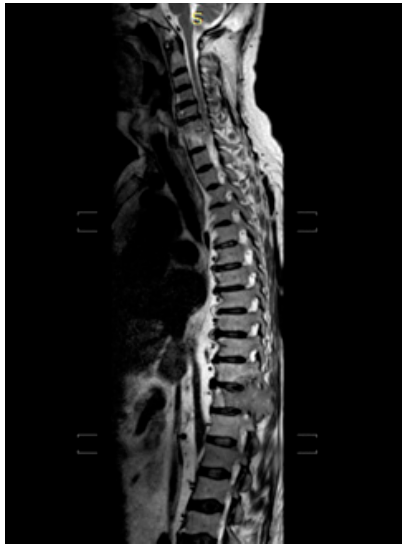
Figure 3. April 2021 MRI of the vertebral column: D12 is partially collapsed with morphostructural alteration and endocanal extrinsecation with considerable mass effect on medullary epiconus and signs of tissue suffering; tissue colonizes costal section of D12 and D11.